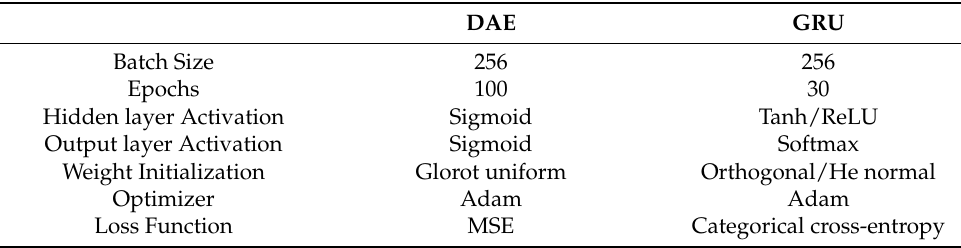
Figure 8. The GRU model of our approach. Table 5. The parameters of both